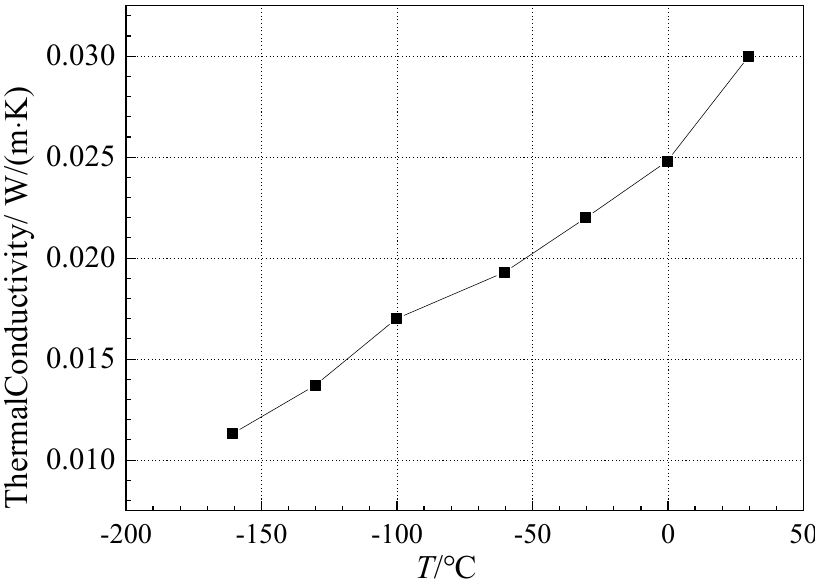
Figure 6. Thermal conductivity of aerogel felt at 50 °C~280 °C under atmospheric pressure. The thermal conductivity measurements of the two materials from − 160 °C to 280 °C are given in Figures 5 and 6. It can be seen that the thermal conductivity of both the ex- truded sheets and the aerogel felt increase with the temperature, and the test range of the measurement device is also verified.